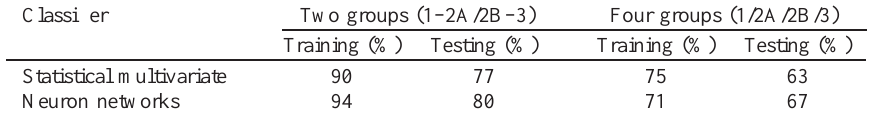
Table 3 The classification accuracy and reproducibility for the combined features in material II